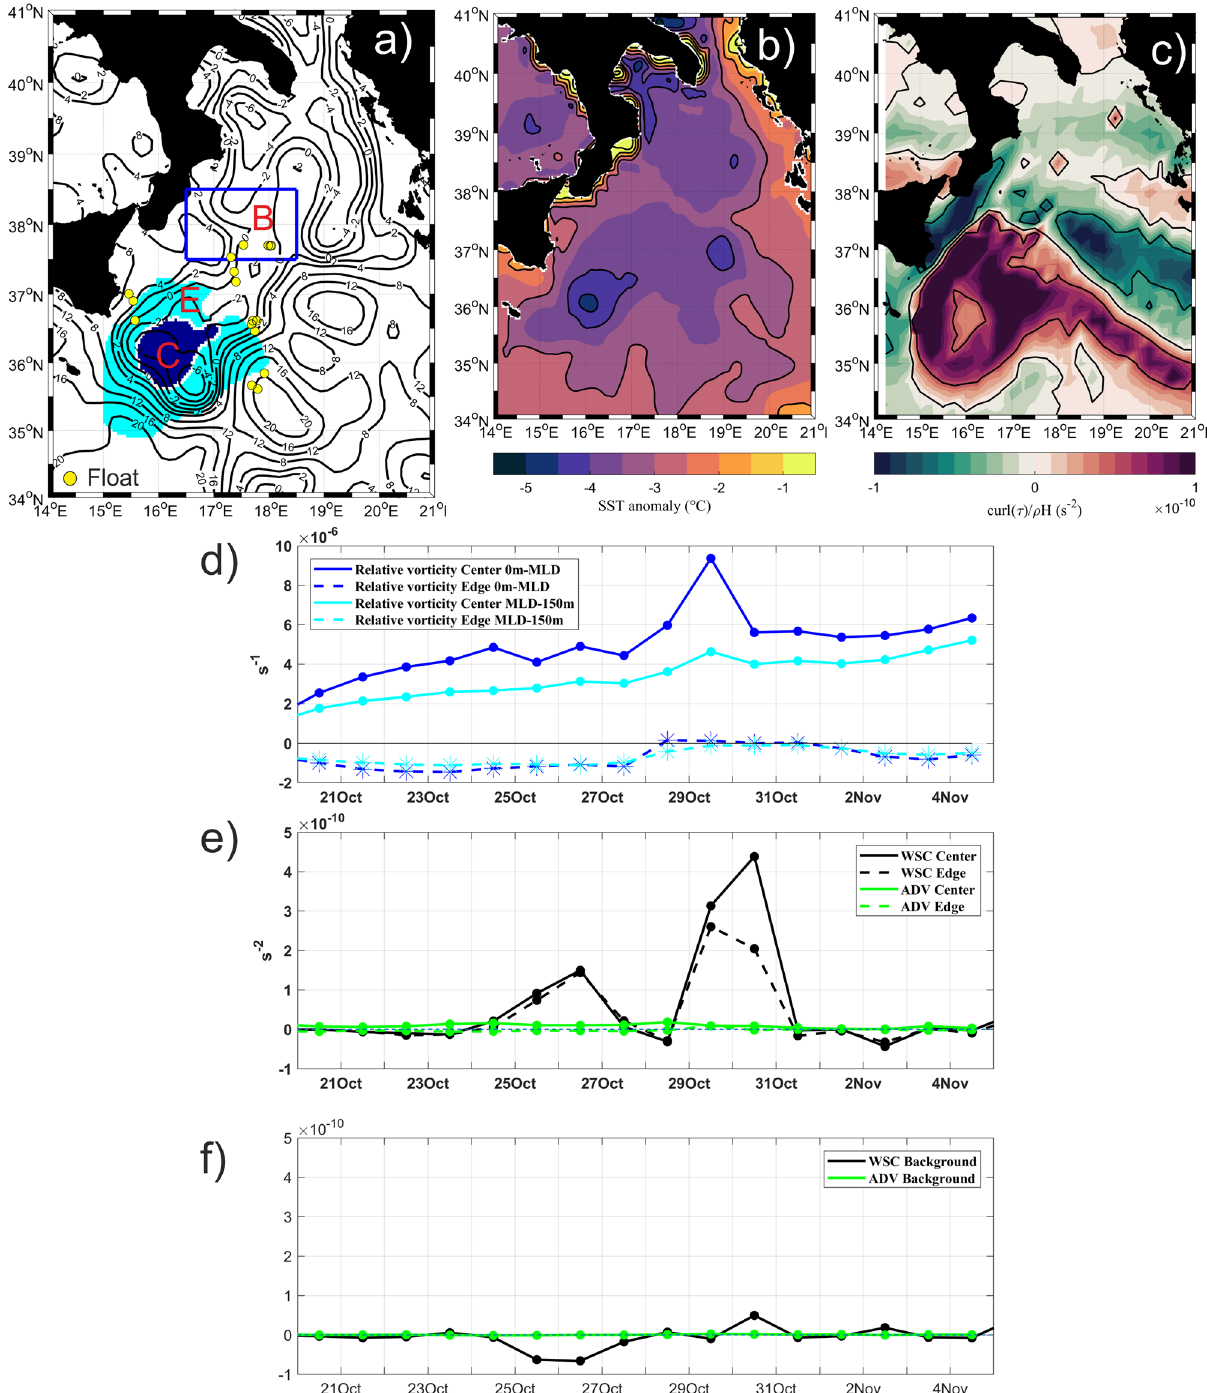
Figure 4. ( a ) Ionian Sea area affected by the Medicane Apollo divided in Center (C, dark blue shaded) and Edge (E, light blue shaded) regions; blue square delimits the area used as Background (B); isolines define the ADT (m) of the northern Ionian on 29 October 2021 and yellow dots show the position of the float cycles available during the event; ( b ) SST anomaly between 29 October 2021 and the mean of the first two weeks of October 2021; ( c ) wind stress curl on 29 October 2021. Time series of the (d ) relative vorticity, ( e ) wind stress curl (WSC), and horizontal advection (ADV) terms of the vorticity equation computed in the Center and Edge and in the ( f ) Background. Positive/negative wind-stress curl is related to the increment of cyclonic/anticyclonic ocean